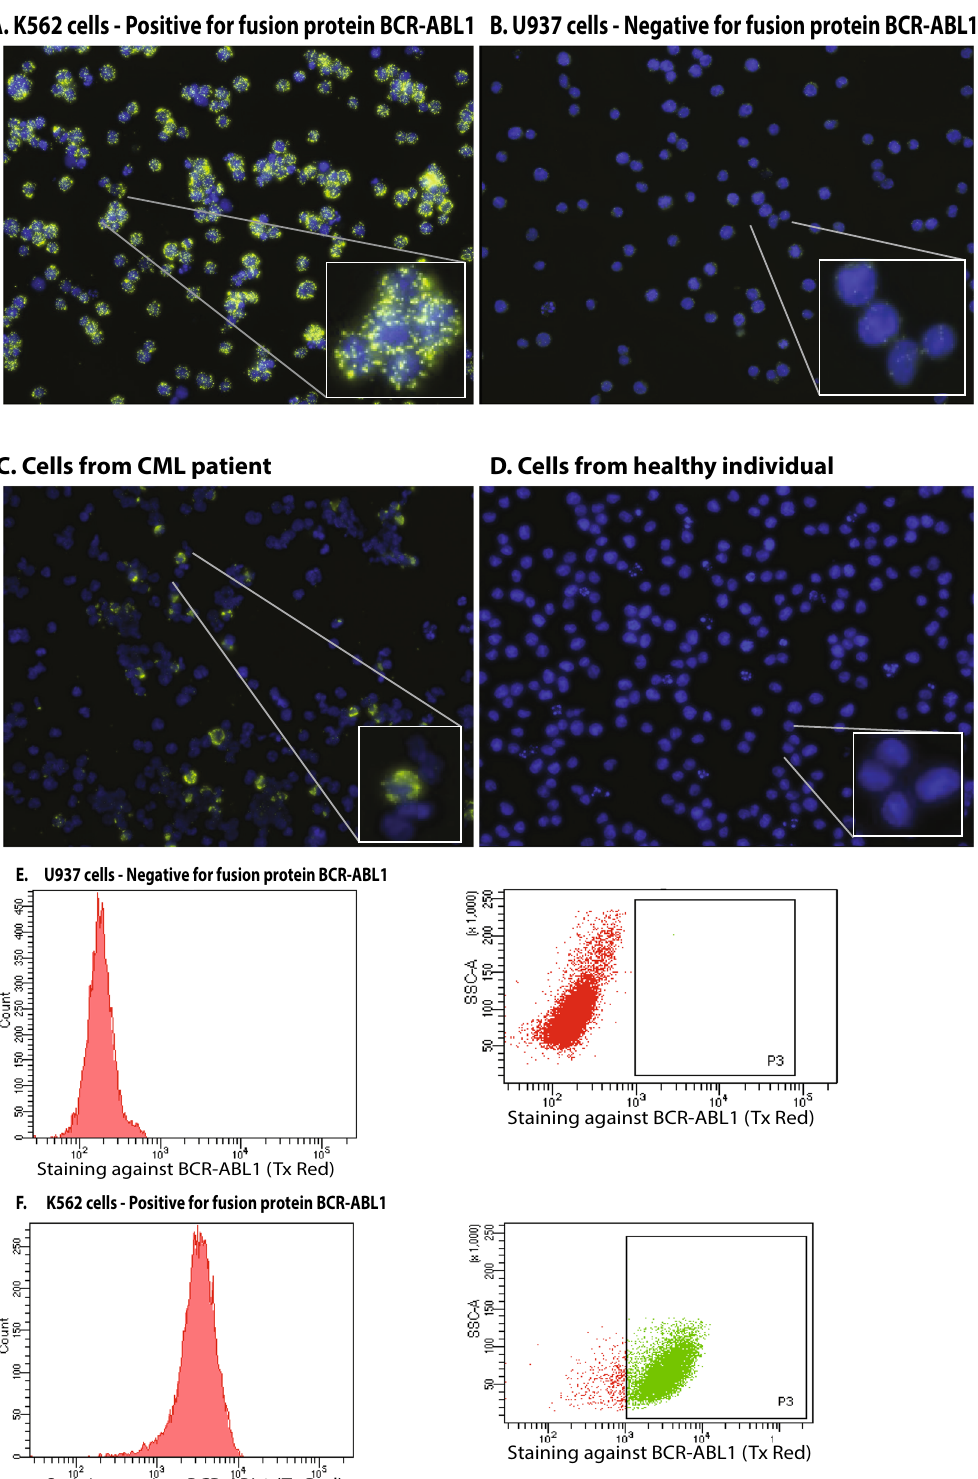
Figure 2. In situ PLA detection by fluorescence microscopy of BCR-ABL1 fusion protein. ( A ) Detection of the BCR-ABL1 positive cell line K562, ( B ) Detection of the BCR-ABL1 negative cell line U937, ( C ) cells from a patient treated for CML, ( D ) nucleated blood cells from a healthy individual. Signals were recorded using ( E ) PLA-flow for detection of BCR-ABL1 in the BCR-ABL1 negative cell line U937 compared to ( F ) the BCR-ABL1 positive cell line K562. Experiments were repeated more than three